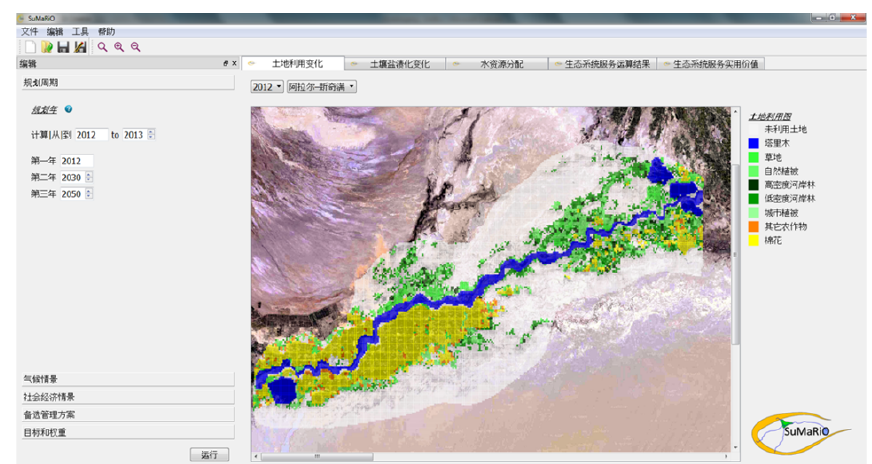
Figure 2. Exemplary representation of the Chinese user interface of the Decision Support System